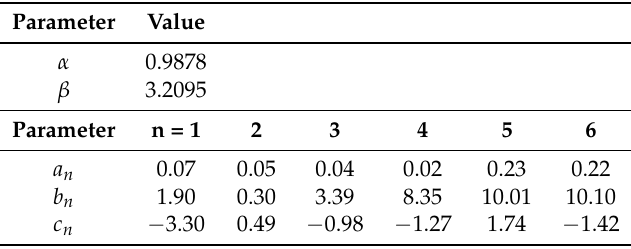
Figure 7. The proposed open-circuit voltage representation: the ( a ) linear term and ( b ) nonlinear term. The nonlinear term of the OCV function is tuned by utilizing the curve fitting tool in MATLAB (2017a academic version, Mathworks, Natick, MA, USA). The corresponding coefficients are listed in Table 2. Table 2. Coefficients of the proposed V OC ( z ) in (6).